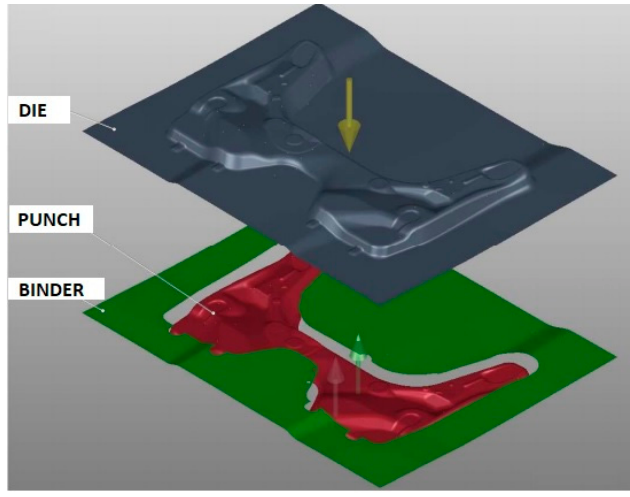
Figure 4. Tools geometry (die, punch and binder or blank